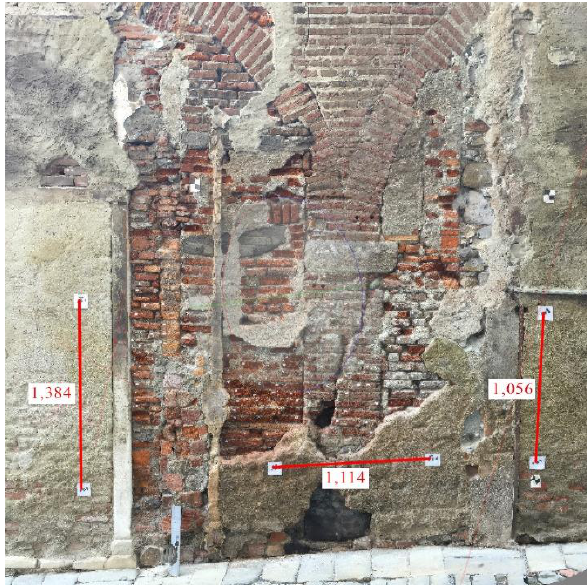
Figure 2. The digital model created by Agisoft PhotoScan software is scaled inserting the distance between couples of coded targets placed on